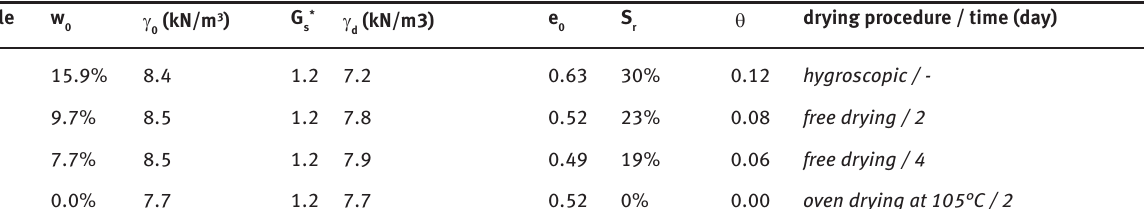
Table 2: Physical-volumetric parameters of the coal cylindrical samples: a) at initial state; b) after imbibition a)